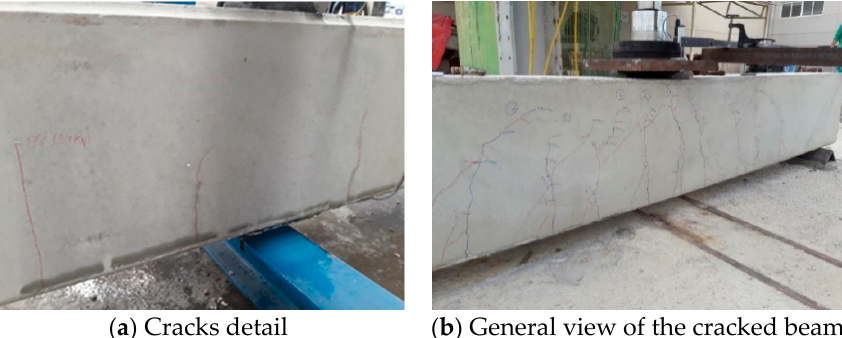
Figure 10. Visual inspection of cracks in 200 × 300 mm and 300 × 500 mm beams.